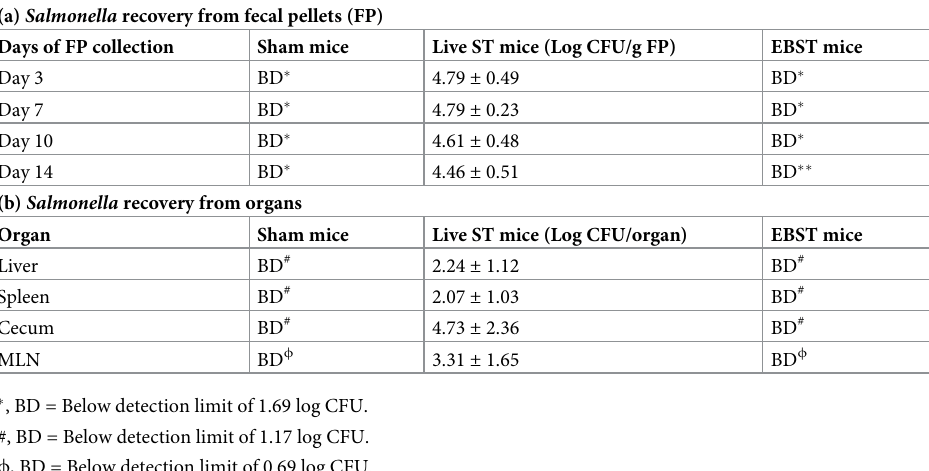
Table 1. Inability of eBeam-inactivated S . Typhimurium (EBST) to multiply in vivo in a Salmonella susceptible mice (C57BL/6J)